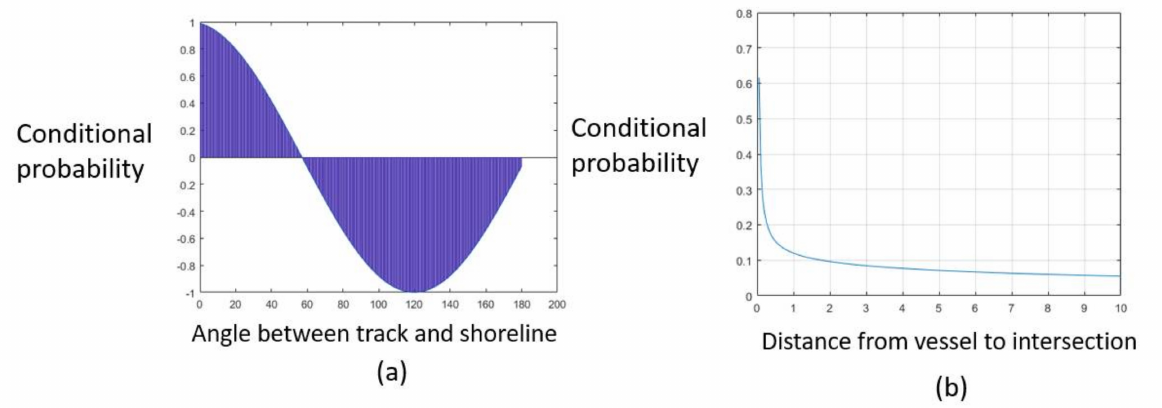
Figure 8. Probability distribution of environmental state quantity. ( a ) Conditional probability distri- bution of ship turning intention and shoreline angle. Negative probability indicates the probability that the ship turns in the opposite direction. ( b ) Conditional probability distribution of ship turning intention and distance to the